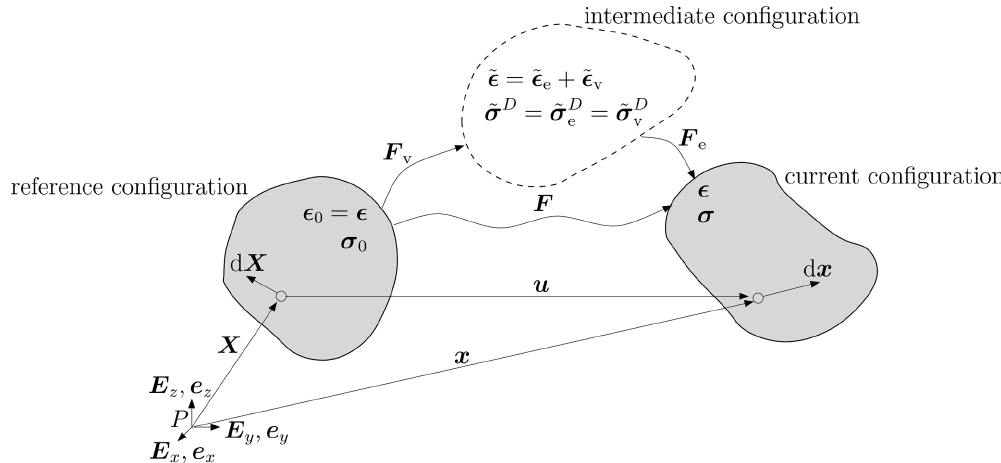
Figure B1. Reference, current, and intermediate configurations and their corresponding strain and stress denotation for the finite viscoelastic Maxwell model. In the intermediate configuration (dashed line) the viscoelastic material equations are defined.